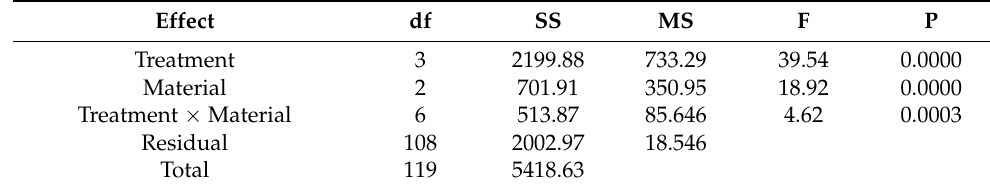
Table A2. Results of Two-way ANOVA for shear bond strength (MPa).